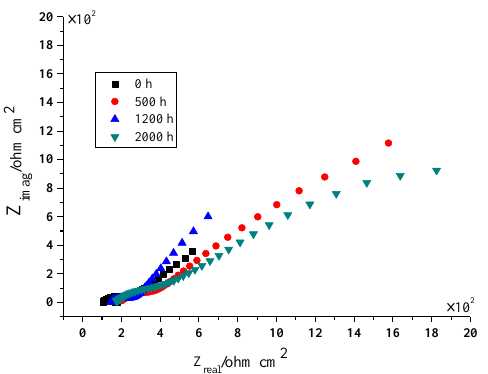
Coatings 2022 , 12 , x FOR PEER REVIEW 9 of 20 charts are composed of a high-frequency single-capacity reactance arc and a low-fre- quency Warburg impedance diffusion arc. The high-frequency impedance spectroscopy reflects the coating information, while the low-frequency impedance spectroscopy reflects the diffusion process of dissolved oxygen in the corrosion products or coating pores. The